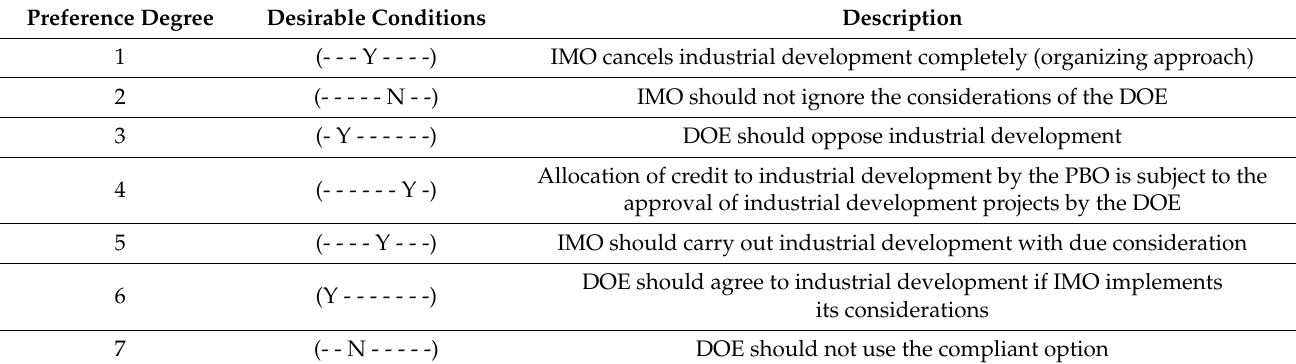
Table 5. DOE preferences (in order from most desirable to most undesirable